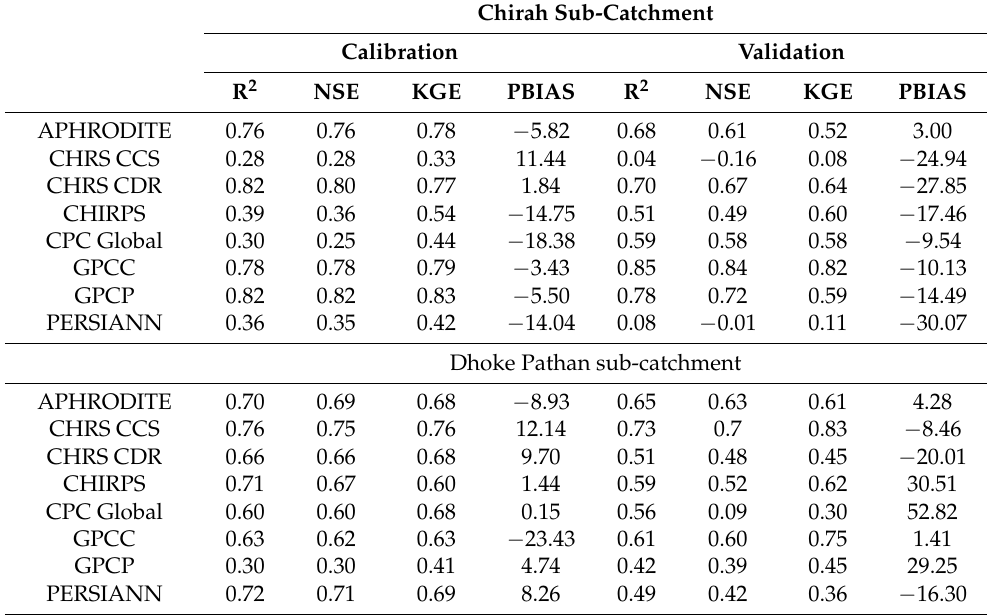
Table 3. Performance of eight PPs in simulating monthly streamflow for Chirah and Dhoke Pathan